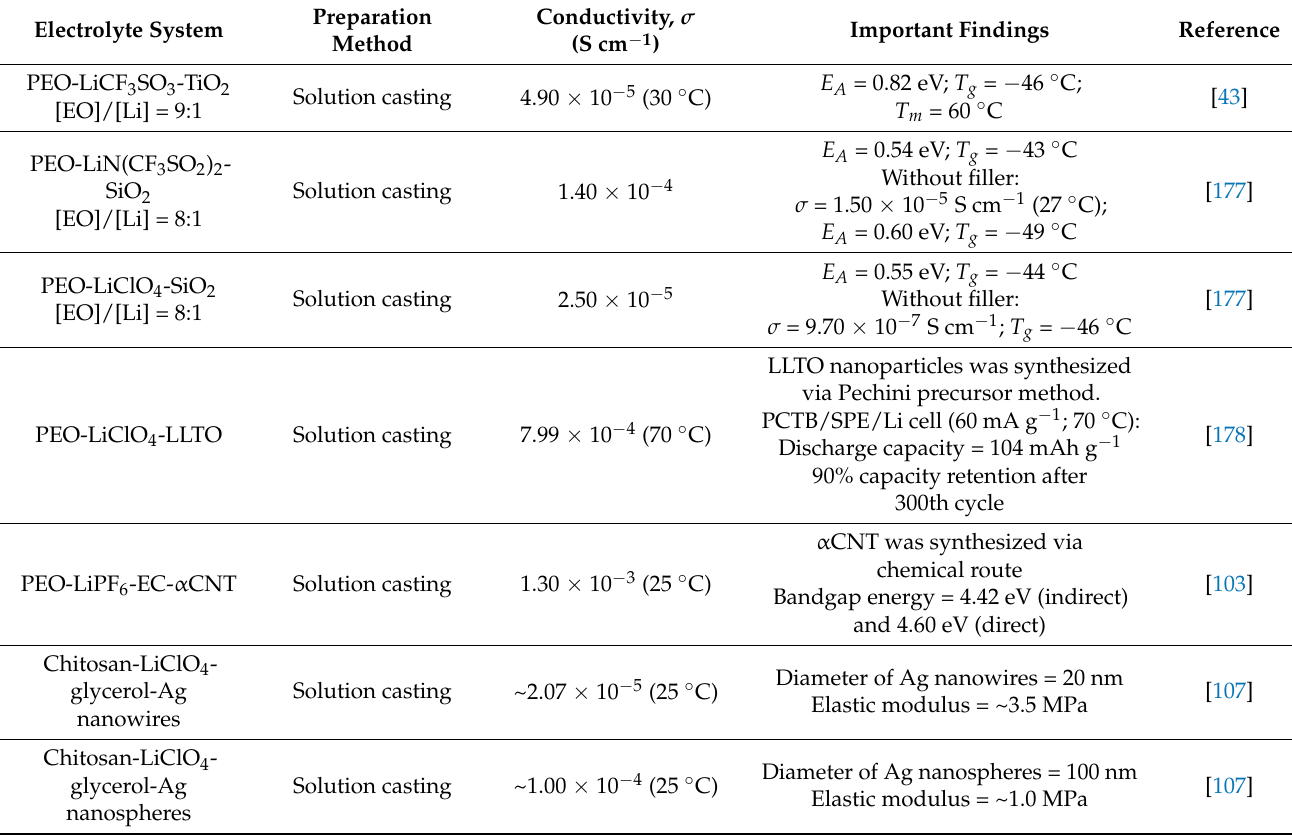
Table 7. Various SPEs systems with fillers